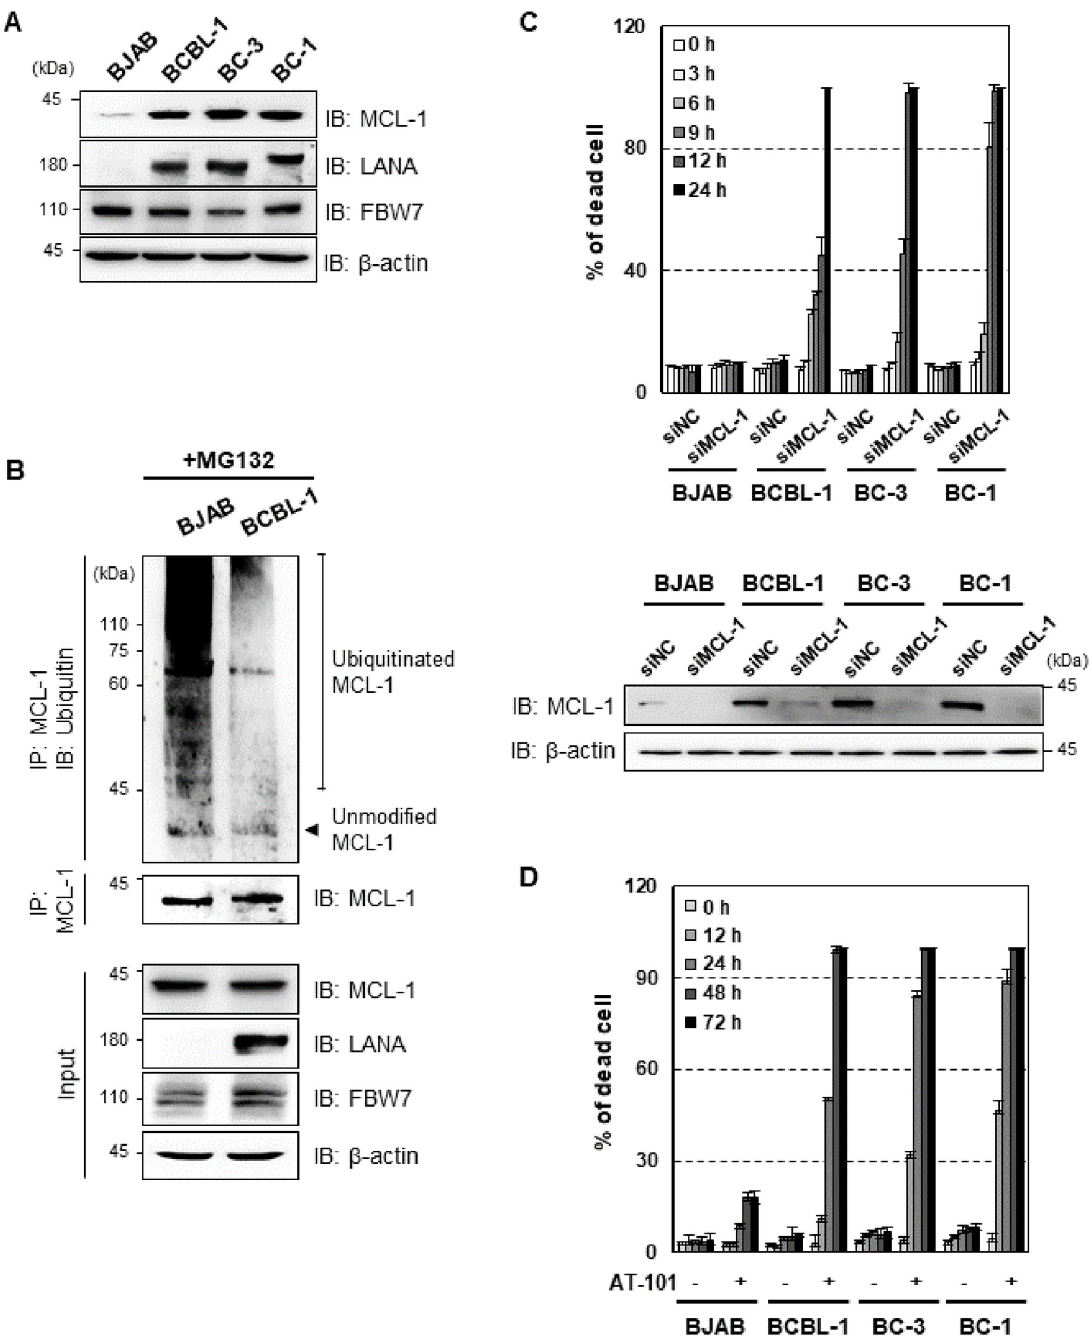
Fig 6. MCL-1 is essential for PEL cell survival. (A) KSHV - BJAB cell, KSHV + PEL cell (BCBL-1 and BC-3), and KSHV + EBV + PEL cell (BC-1) lysates were subjected to IB with anti-LANA and anti-MCL-1 antibodies. β -actin is shown as a loading control. (B) The cells were treated with MG132 (10 μ M), followed by IP with an anti-MCL-1 antibody and IB with an anti-ubiquitin antibody. (C) BJAB and KSHV- infected PEL cell lines were transfected with negative control siRNA or siRNA that target MCL-1 (100 pmol) for the indicated periods of time, followed by staining with trypan blue solution. The effect on MCL-1 protein was determined by counting of trypan blue-stained cells. Cells were transfected with scrambled or MCL-1 siRNA for 12 h, followed by immunoblotting (IB) with anti-MCL-1 or anti- β antibodies. (D) Cells were treated with 10 μ M AT-101 (MCL-1 inhibitor) for the indicated periods of time and then stained with trypan blue solution.